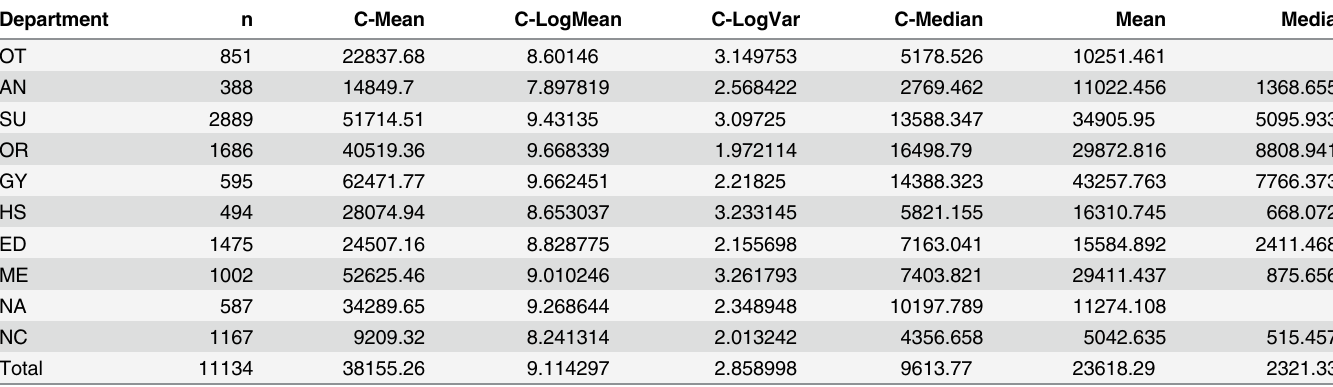
Table 14. Descriptive statistics of amounts by department identified as significant by the model.